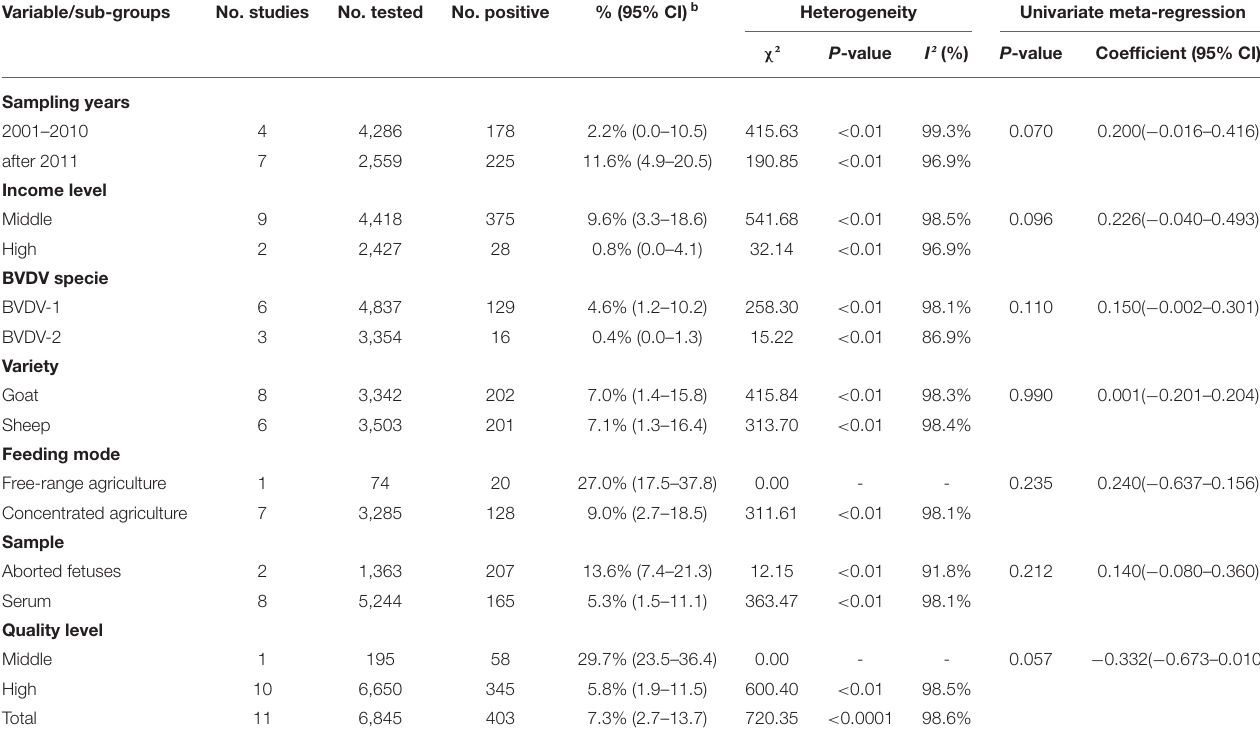
TABLE 6 | Association of different variables in the prevalence of BVDV infection in sheep and goats worldwide (Molecular methods).